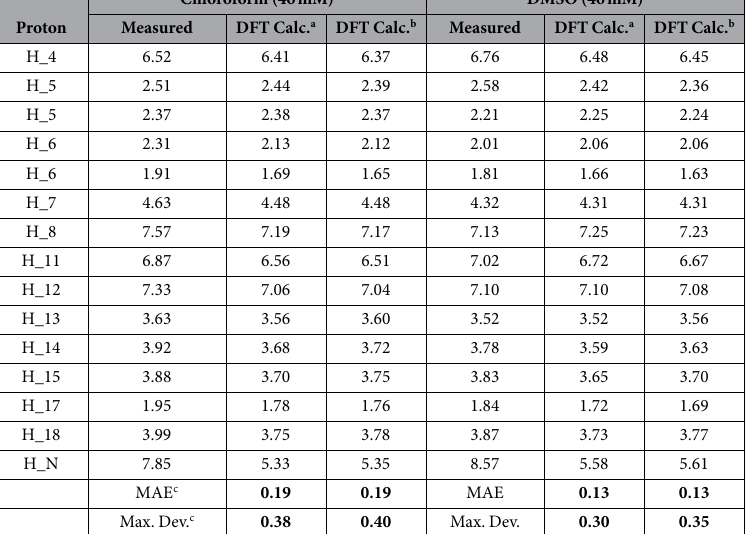
Table 1. 1 H Experimental and DFT calculated chemical shifts for colchicine in chloroform and DMSO solvents using two functional and basis set combinations. a Mpw1pw91/6-311 + g(2d,p) with IEPCM chloroform or dmso solvation. b B3LYP/6-311 + g(2d,p) with IEPCM chloroform or dmso solvation. c Does not include NH proton.